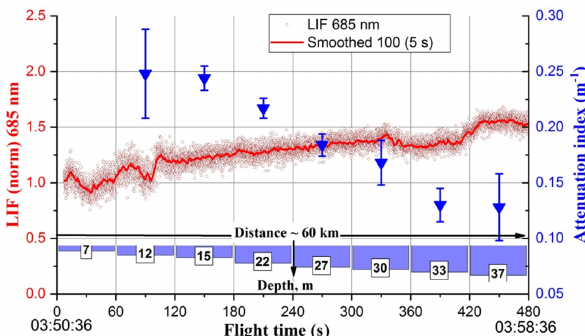
Figure 21. Relative chlorophyll concentration and the water extinc- tion coefficient in the Anadyr Bay of the Bering Sea according to laser sensing data on 16 September